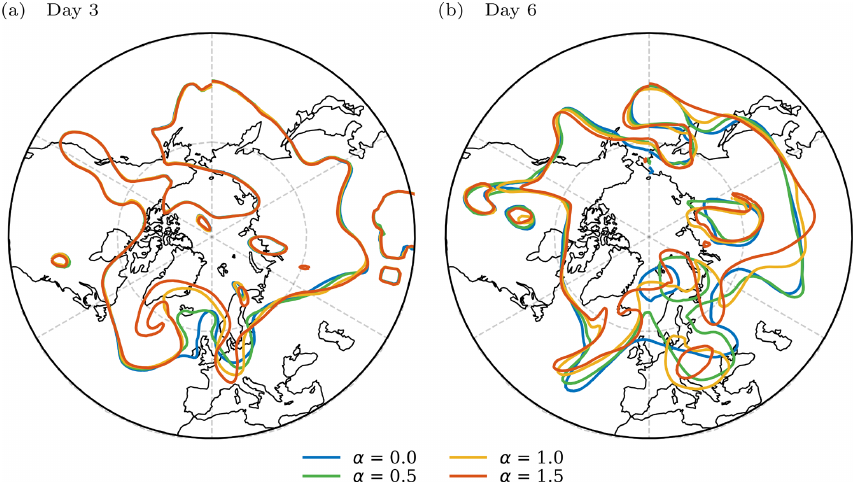
Figure 6. Dynamical tropopause (upper-level 2pvu contour) for Thor onset on (a) 3 October 2016 (day 3) and (b) 6 October 2016 (day 6) for different α values (blue for α = 0 (NOLH), green for α = 0 . 5, yellow for α = 1 (CNTRL), and red for α = 1 .